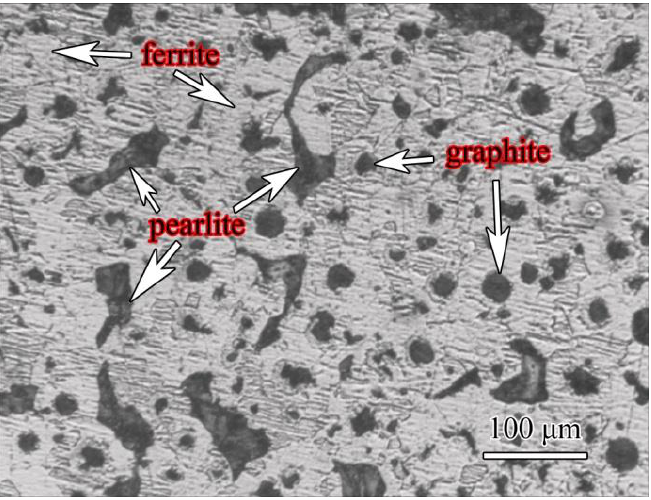
Figure 1. Optical micrograph demonstrating the microstructure of the substrate material.